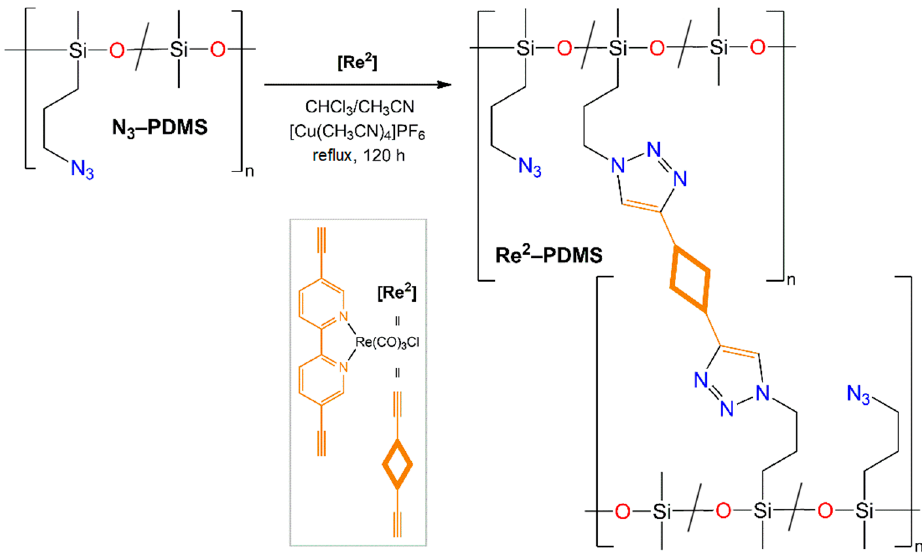
Figure 3. ( A ) FTIR and ( B ) emission spectra ( λ ext = 365 nm, r.t.) of Re1-PDMS and Re2-PDMS.